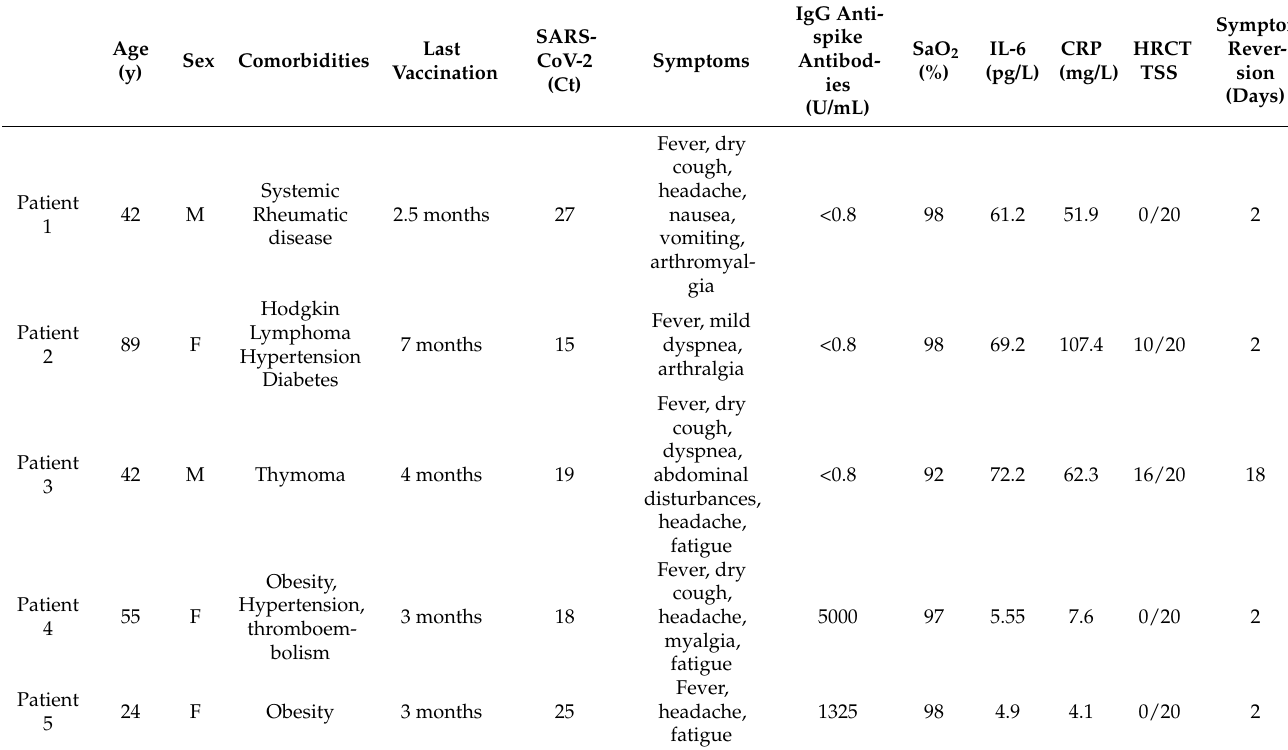
Table 1. Patient analyses and clinical